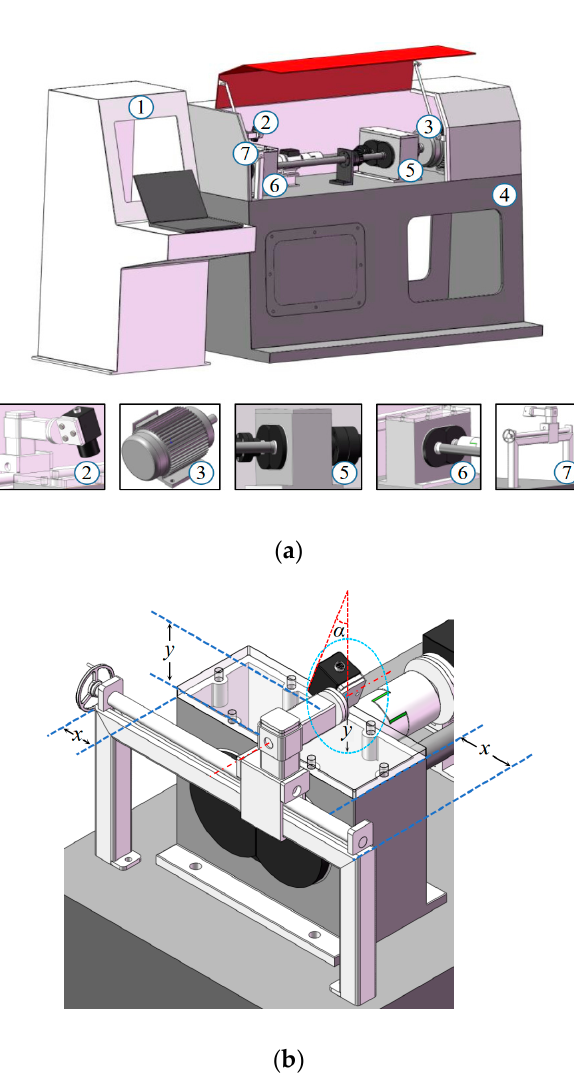
Figure 2. Schematic diagram of the end-to-end implementation process of quantitative detection of gear pitting. ( a ) Schematic diagram of gear pitting detection platform (TVDP) in whole and part; ( b ) structure diagram of gear pitting visual detection platform.